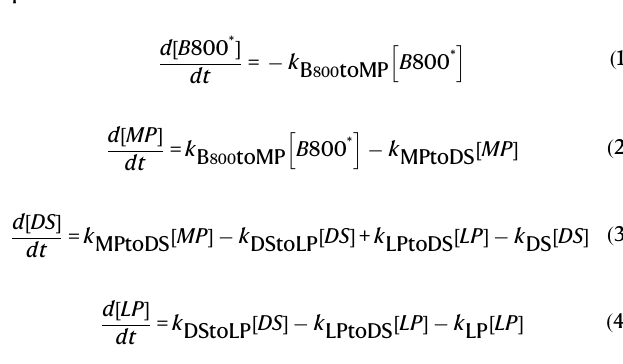
Fig. 3 | LH2 polariton dynamics. Pumpprobekinetics (scattered markers) ofbare LH2 fi lmandangledcavityat30°withpumpexcitationat785nm(8.5uJ/pulse/cm 2 ) and probe at a 875nm and b 830nm (the inset shows the kinetic signal in the fi rst